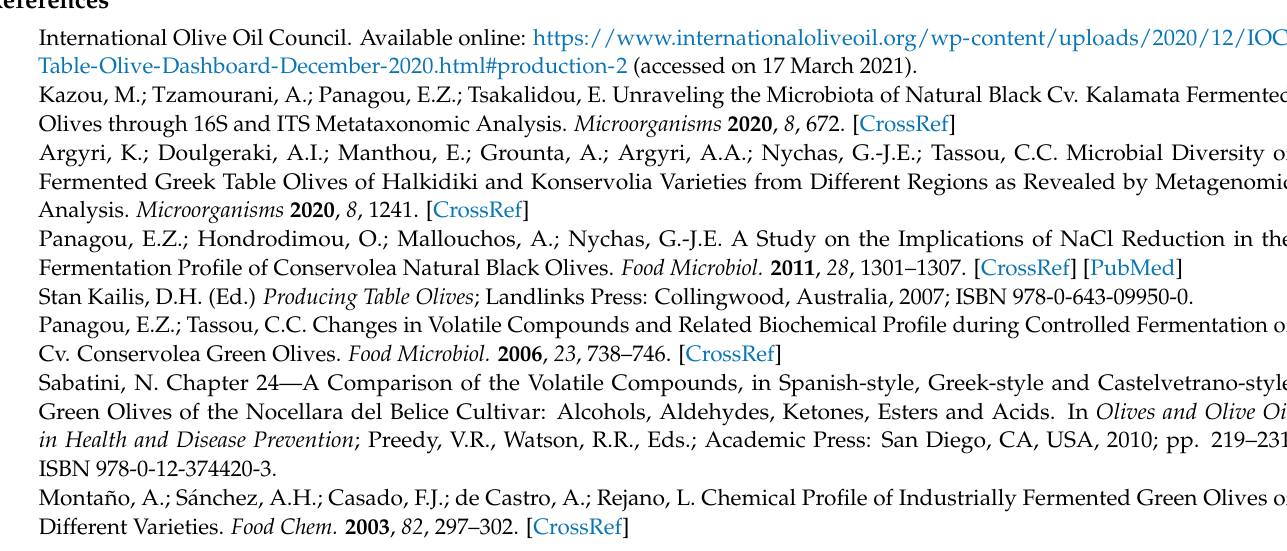
cv. Conservolea and cv. Halkidiki table olives. Figure S2: PCA loadings plots of the volatile compounds identified in industrially fermented table olives from different cultivars: ( a ) Loadings 1 vs Loadings 2; ( b ) Loadings 1 vs Loadings 3. Figure S3: Heatmap plot of hierarchical cluster analysis performed on volatile compounds of table olives from CNS (cv. Conservolea), HLK (cv. Halkidiki) and KLM (cv. Kalamata) cultivars. Sample codes are given in Table 1. Variables codes are given in Table 2. Figure S4: Heatmap plot of hierarchical cluster analysis performed on volatile compounds of cv. Conservolea table olives from Northern Evia (EVIA), Fthiotida (FTH) and Magnesia (MAG) growing locations. Variables codes are given in Table 2. Figure S5: Principal component analysis of the volatile compounds identified in cv. Halkidiki green olives grown in Halkidiki (HAL) and Kavala (KAV): ( a ) scores plot and ( b ) loadings plot of the first vs third principal component. The codes of variables are given in Table 2. Figure S6: Heatmap plot of hierarchical cluster analysis performed on volatile compounds of cv. Halkidiki table olives from Halkidiki (HAL) and Kavala (KAV) growing locations. Sample codes are given in Table 1. Variables codes are given in Table 2. Figure S7: Principal component analysis of the volatile compounds identified in cv. Kalamata natural black olives grown in Aitoloakarnania (AIT—red dots) and Southern Peloponnese (PEL—green dots). The shaded areas represent the 95% confidence ellipses. Figure S8: Influence plot of F-residuals vs. Hotelling’s T2 statistics for PCA presented in: ( a ) Figure 2, ( b ) Figure 3 and ( c ) Figure